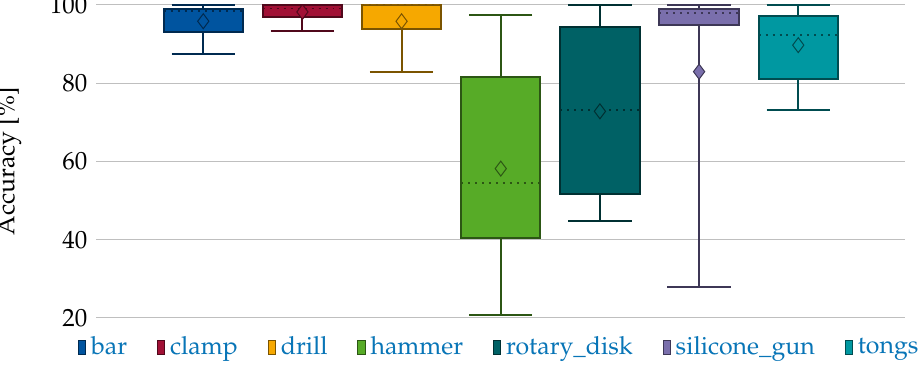
Figure 16. Accuracy measures for the classified items without rotary table full and